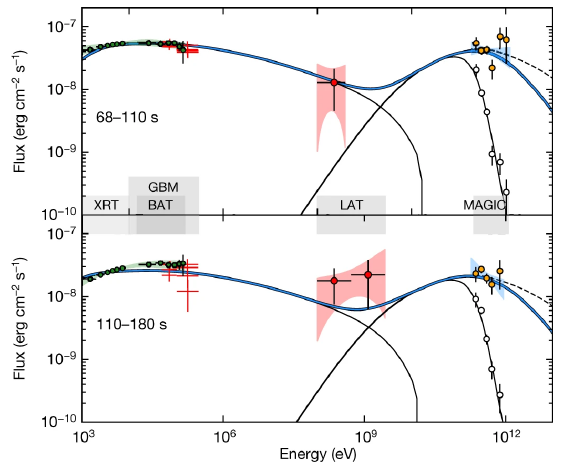
Figure 21. GRB190114C: modeling of two SEDs in consecutive time intervals. The different curves refer to: the observed spectrum (thin solid line), the EBL deabsorbed spectrum (thick blue line) and the SSC component neglecting the effects of internal γ - γ opacity (dashed line). From [71].